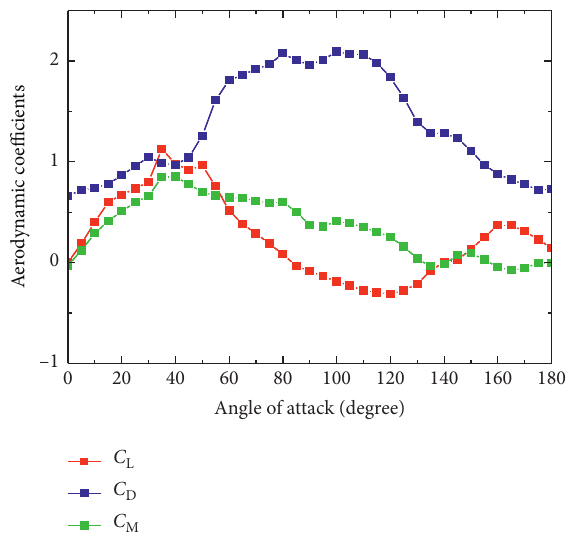
Figure 7: Aerodynamic coefficients at the central axis of the quad